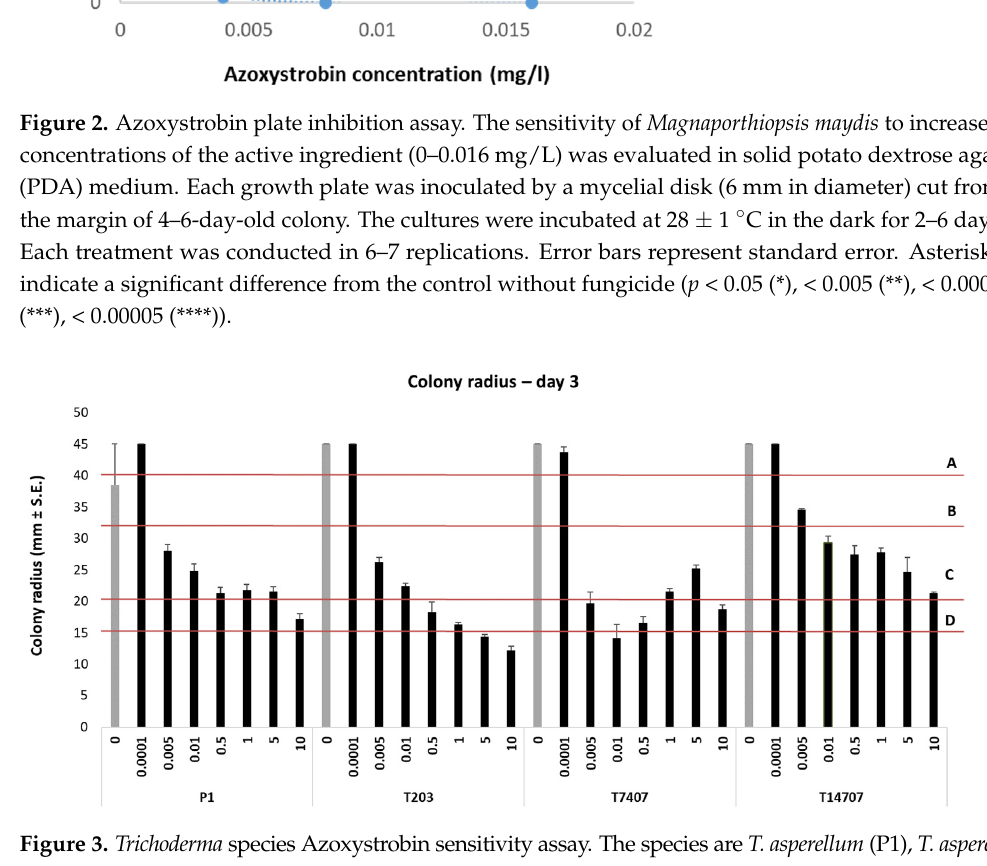
asperelloides (T203), T. longibrachiatum (T7404), and Trichoderma sp. O.Y. 14707 (T14707, see Table 1). The active